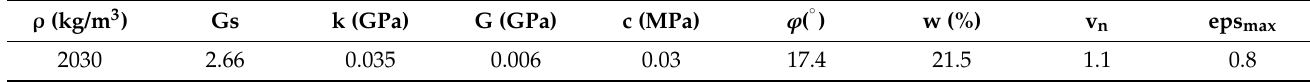
Table 4. Clay medium parameters.